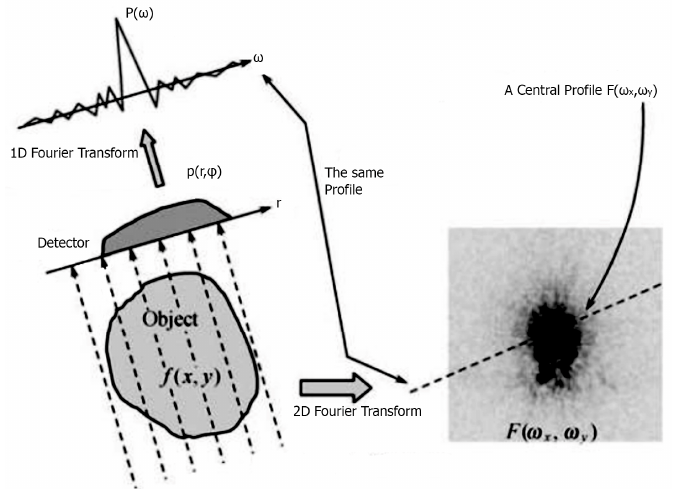
Figure 4. Central section theorem in two dimensions.